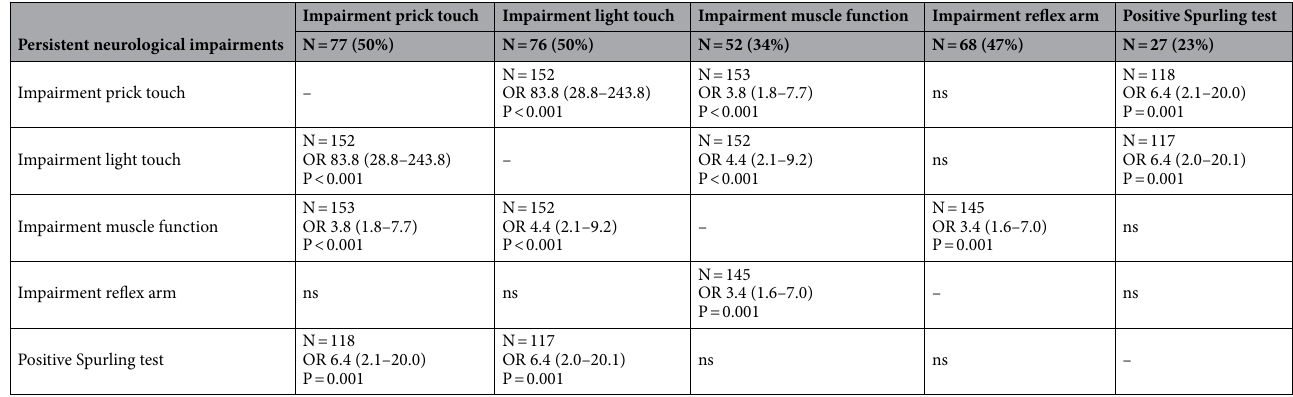
Table 3. Univariate associations between persistent neurological impairments at one year follow-up among participants with cervical radiculopathy who underwent surgery and postoperative rehabilitation. Results are presented with odds ratio (OR), 95% confidence interval, and p